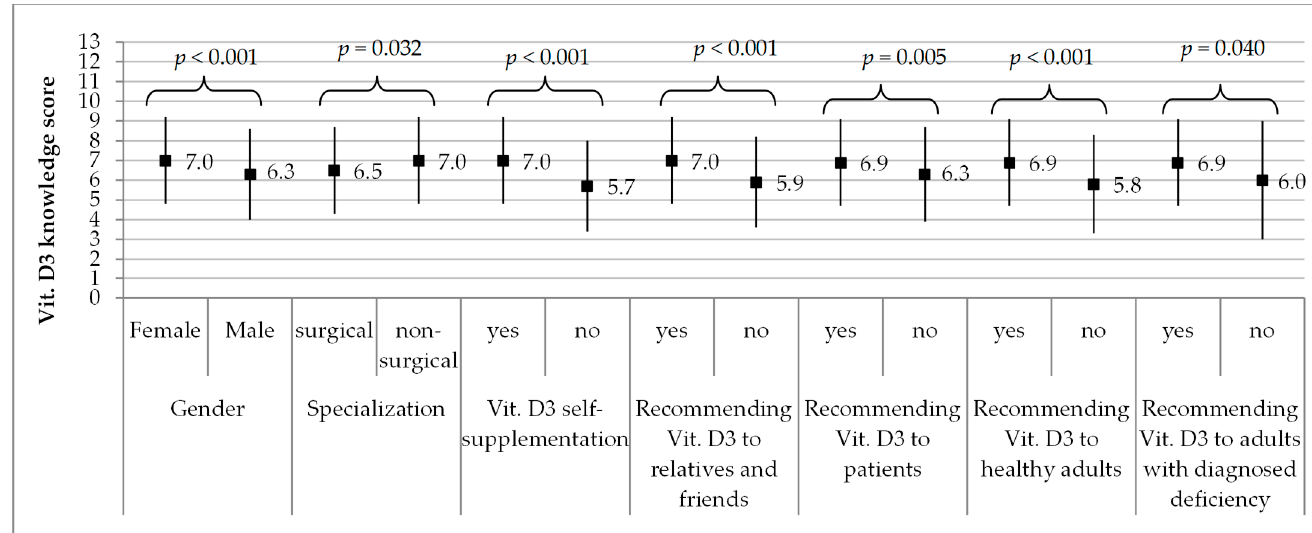
Significantly higher scores in vitamin D knowledge were obtained by females (7.0 ±